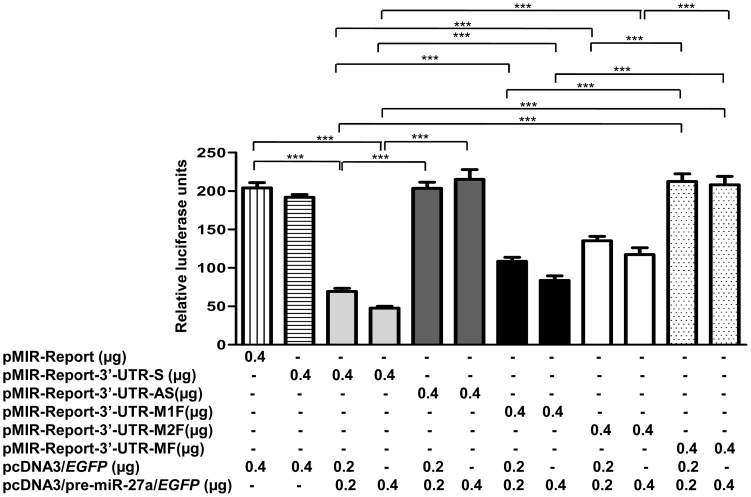
miR-27a targets both the seed regions of MCPH1 cloned together.The luciferase reporter assay of different constructs of the full-length 3′-UTR of MCPH1 in KB cells. Note a significantly reduced luciferase activity in cells co-transfected with pMIR-Report-3′-UTR-S and pcDNA3/pre-miR-27a/EGFP (0.2 or 0.4 µg) in comparison to those with pMIR-Report or pMIR-Report-3′-UTR-AS, suggesting miR-27a targets MCPH1. Note that both the seed regions in the 3′-UTR of MCPH1 are important for the interaction with miR-27a as a significant increase in the luciferase activity was observed in cells transfected with pMIR-Report-3′-UTR-M1F, pMIR-Report-3′-UTR-M2F or pMIR-Report-3′-UTR-MF along with pcDNA3/pre-miR-27a/EGFP in comparison to cells transfected with pMIR-Report-3′-UTR-S and pcDNA3/pre-miR-27a/EGFP. Abbreviations: ns, statistically not significant; and, ***p<0.001.